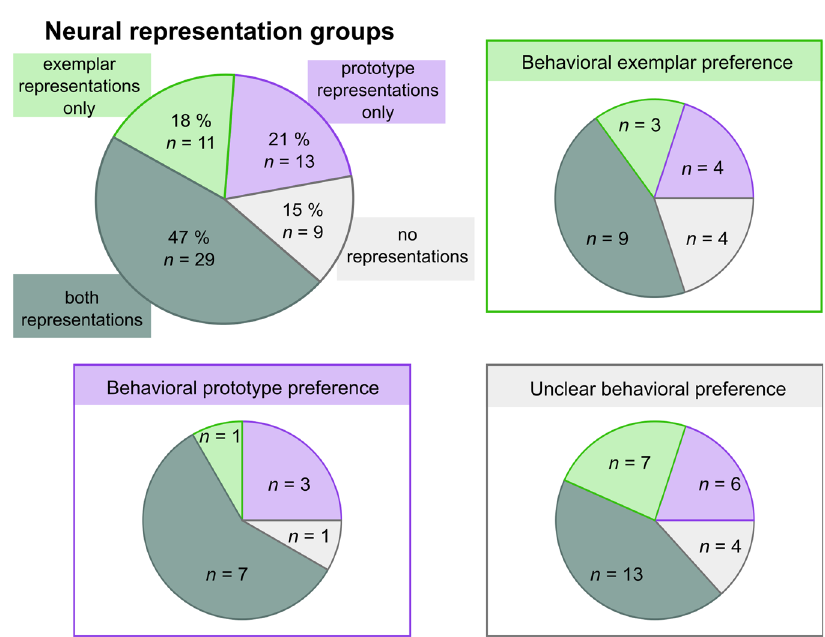
Fig. 4 Neural representation groups organised by behavioural preference groups ( n = 62 individuals) based on Δ DIC ≥ 5. The pie charts depict the proportion of individuals showing only exemplar representations in green, only prototype representations in purple, the presence of both representations in dark turquoise, and the presence of neither representation type in grey. Supplementary Fig. 1 additionally depicts the subgrouping of neural representation groups when no threshold for the Δ DIC is